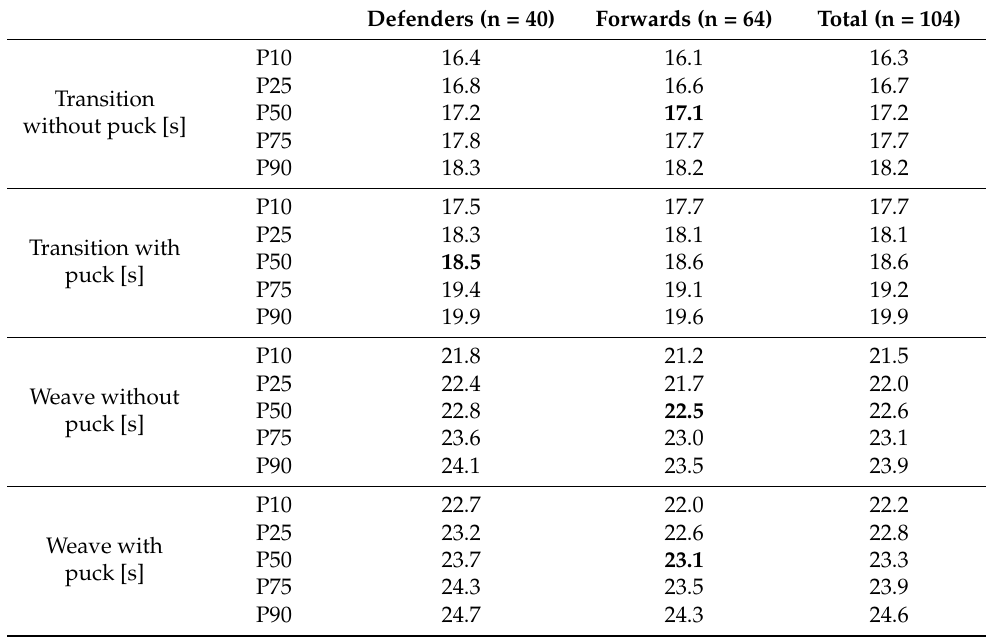
Table 3. Percentile data of agility performance by playing position. Based on the 50th percentile, performance maxima marked in